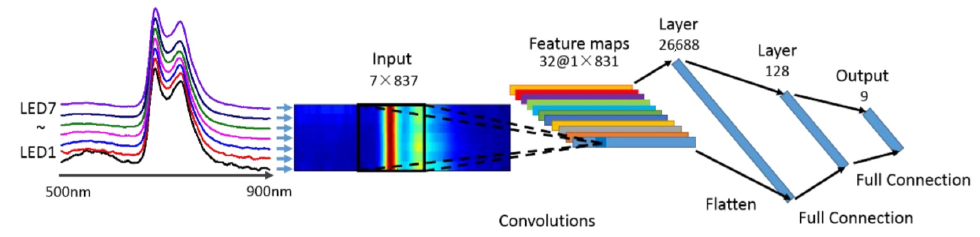
Figure 2. The architecture of our designed CNN.